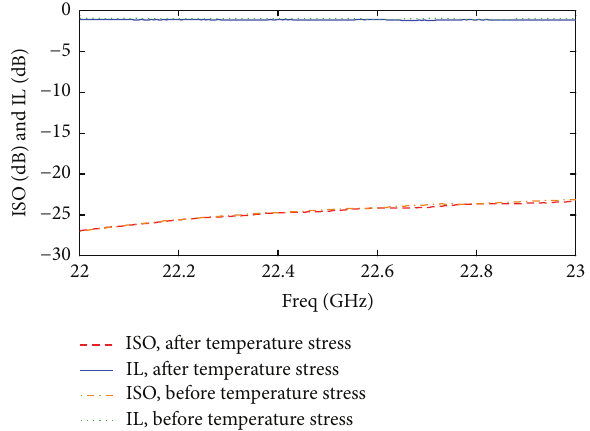
Figure 10: The insertion loss and isolation against frequency before (blue color traces) and after (red color traces) temperature